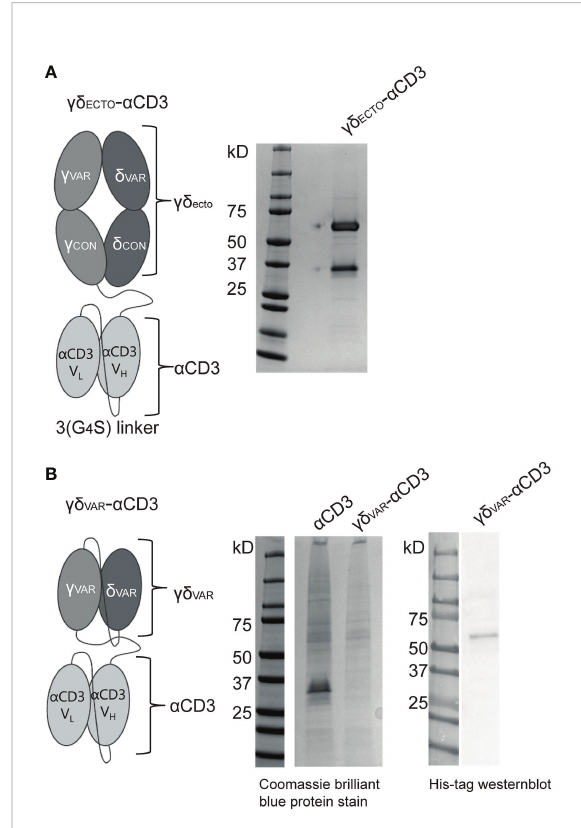
FIGURE 1 Expression of a gd Var – a CD3 bispeci fi c molecule (A) Schematic representation of the gd ecto - a CD3, showing the extracellular (ecto) gd TCR (top), with the TCR g chain connected to an anti-CD3 single chain variable fragment ( a CD3) with the variable light (V L )and heavy (V H ) and light chain (bottom) via a fl exible linker. Puri fi ed GAB was run on SDS-page gel and stained with coomassie brilliant blue protein stain: visualizing the ecto g -CD3scFV (59kD) and ecto d chain (26 kD). (B) Schematic representation of the gd var – a CD3 with the V d -V g single chain TCR fragment (scTv) (top) linked to an anti-CD3 scFv (bottom) via a fl exible linker. After HIS-tag puri fi cation the CD3scFv and gd Var – a CD3 samples were run on SDS gel and visualized with coomassie brilliant blue protein stain. (left) or His-Tag western blot